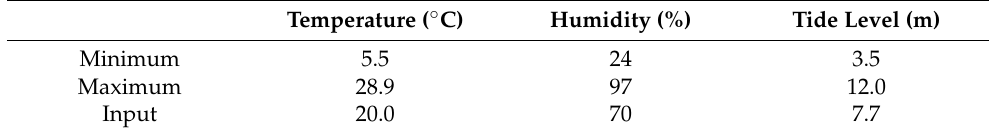
Table 3. Environment conditions for in situ data and corresponding model input values.